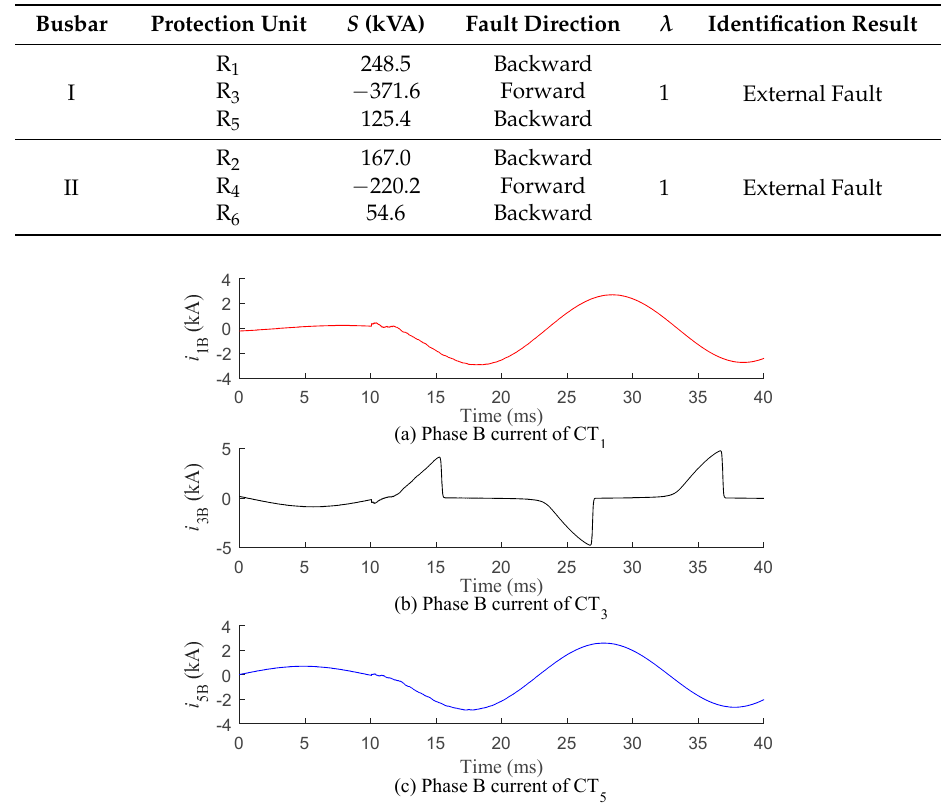
Figure 11. The phase B currents of CT 1 , CT 3 , and CT 5 for a phase B fault on l 3 , on the condition of phase B saturation of CT 3 .